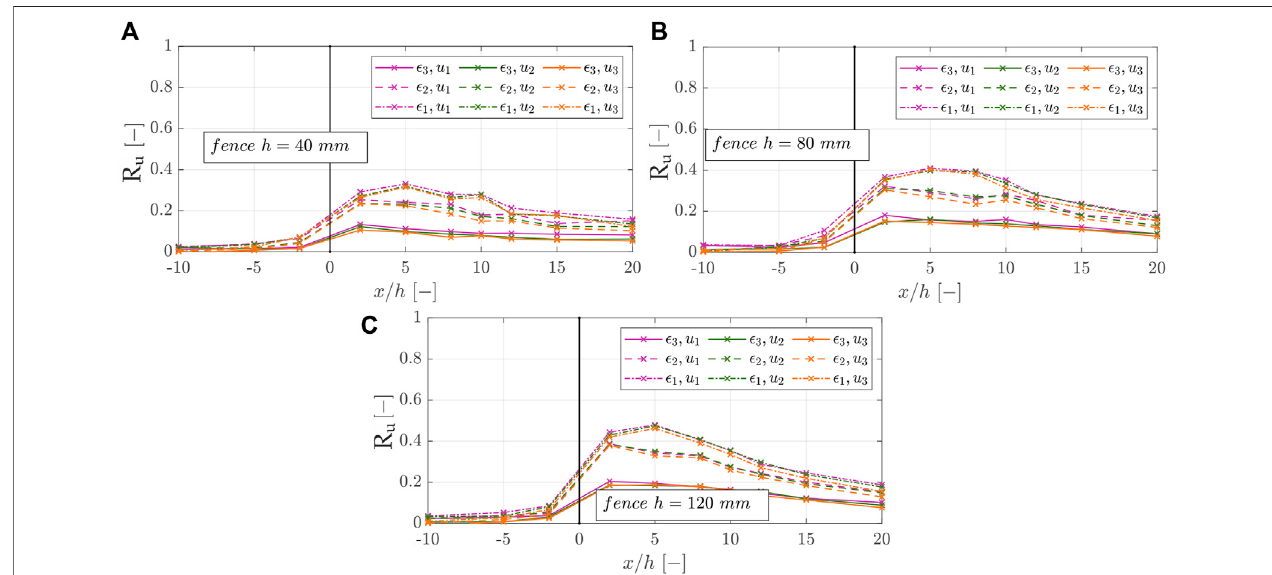
FIGURE 11 | Wind reduction coef fi cients accordingly to Eq. 9 in the x -direction of fences with different characteristics, which are divided into (A) the fence heights h